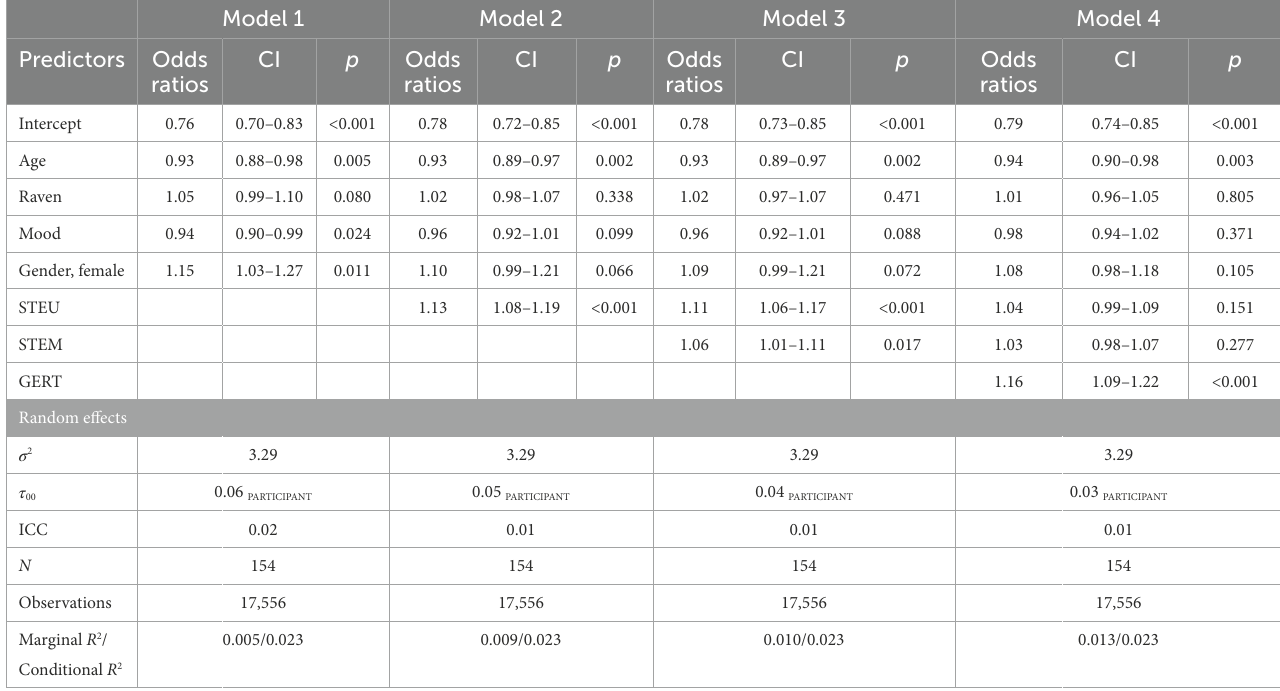
TABLE 2 Mixed logistics models testing the influence of EI on accuracy in the FEB